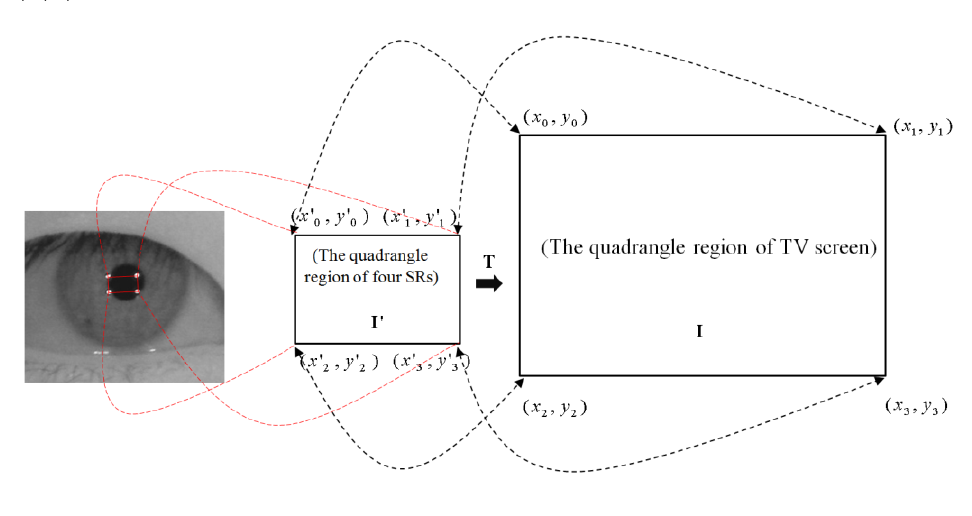
Figure 11. Mapping relationship between TV screen region and quadrangle region of four SRs